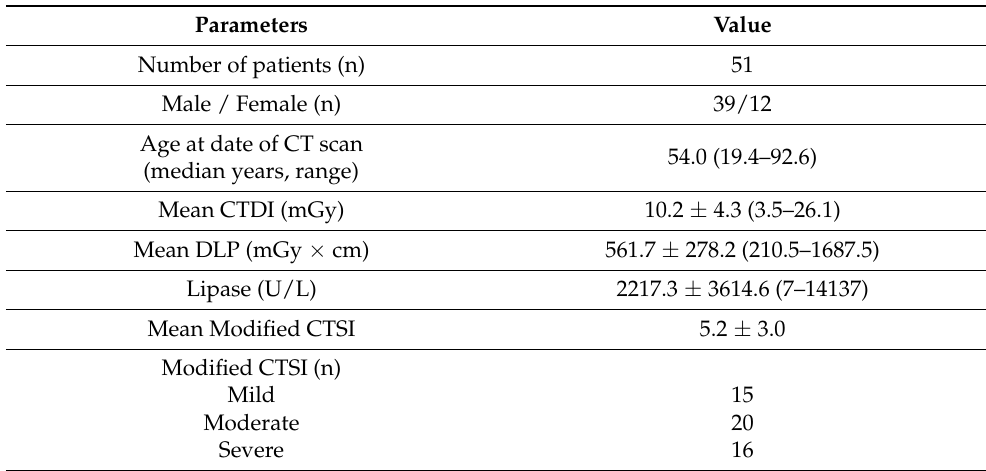
Table 1. Patient